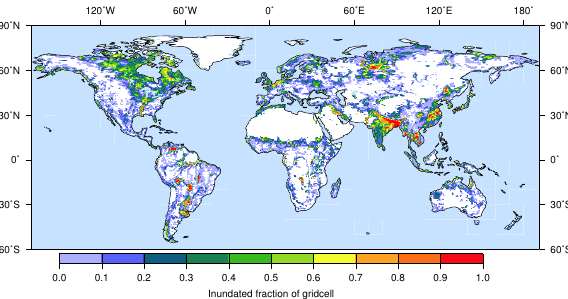
Fig. 1. Mean annual maximum fraction of inundated land between 1993 and 2004 identified by a multi-satellite approach (Papa et al., 2010). White areas indicate areas of no inundation.